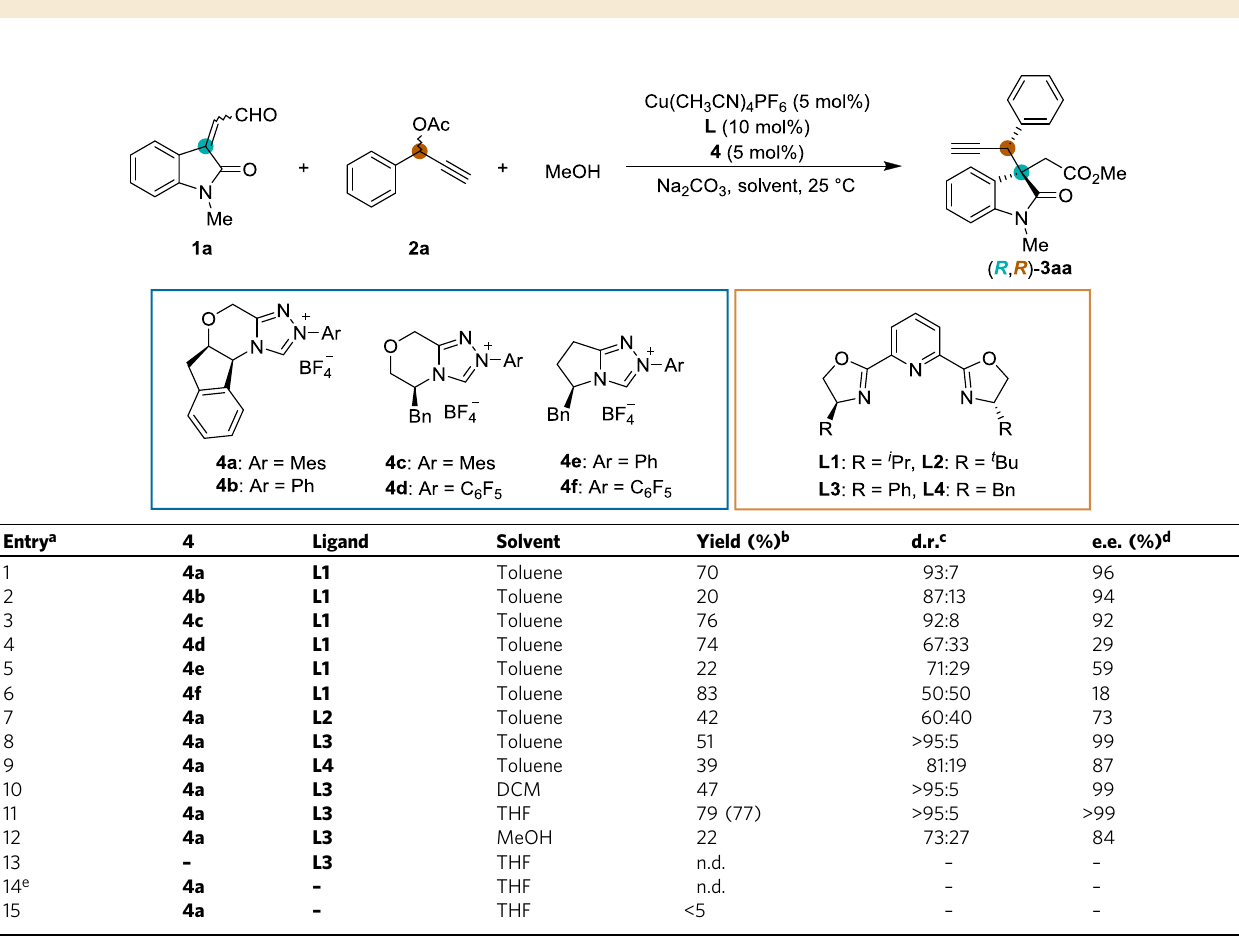
Table 1 Reaction